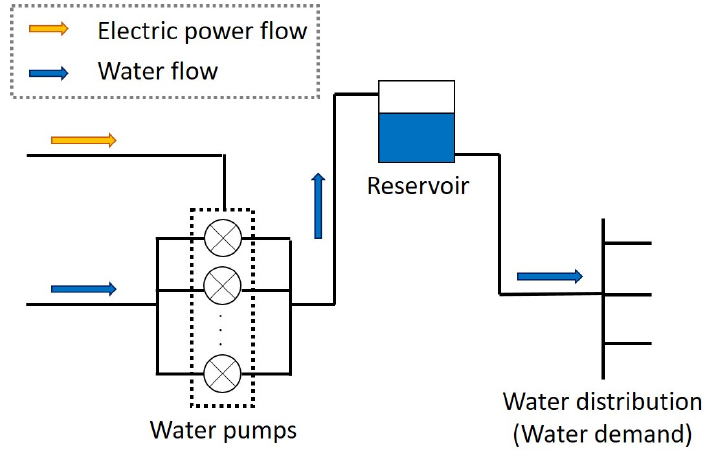
Figure 1. Assumed water distribution